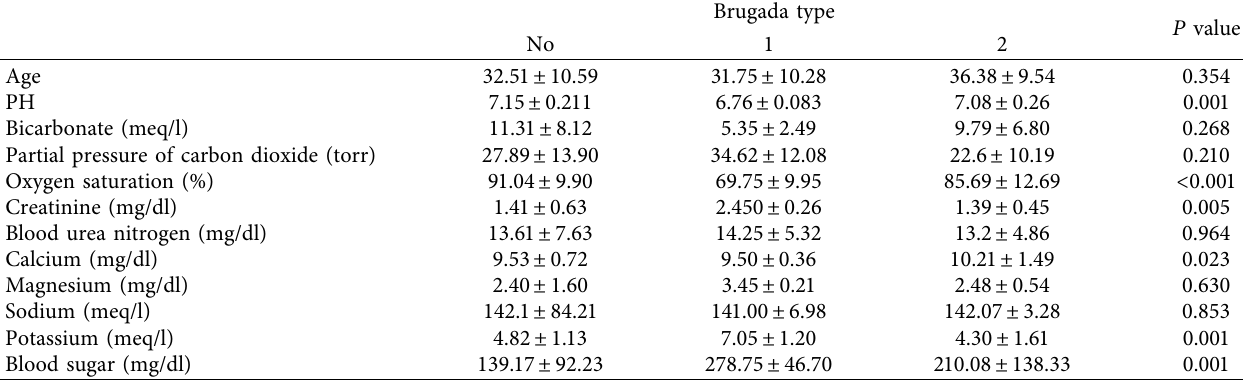
Table 2: Comparison of age and laboratory data between various types of Brugada